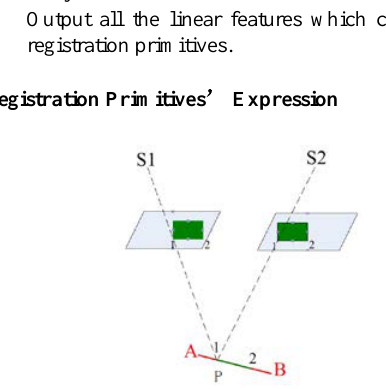
Figure 4 ． The line AB on the LiDAR point data and the corresponding points in the image space Firstly, take line AB （ Figure.5 ） extracted from LiDAR points Figure 1: extraction of linear features. The red ones are the ideal data as a line in object space. As points data is three- linear features dimensional data, AB is three-dimensional line. P, a point in AB, has a correspondent corresponding image point P ′ in